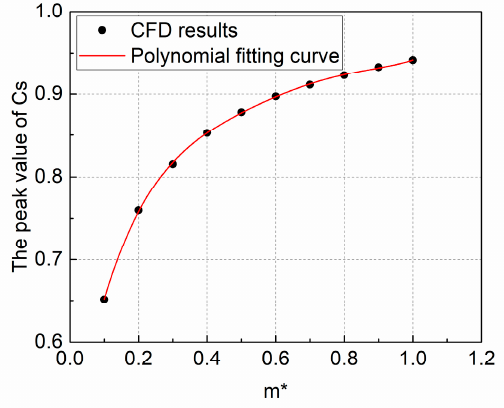
Figure 19. The relationship between the peak value of and the non-dimensional mass.